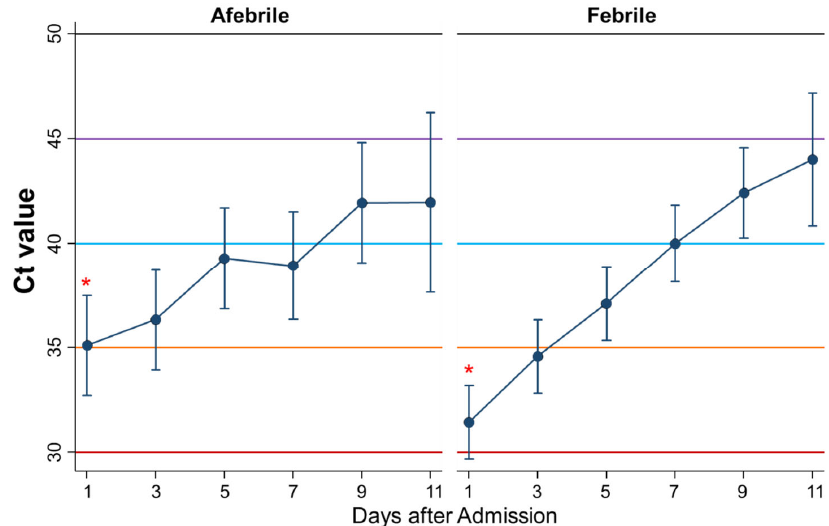
Figure 4. Differential kinetics of the Ct values between afebrile and febrile patients. Mean Ct with 95% confidence intervals. When the Ct value is 40 or more, the PCR test result is considered negative. * represents a significant difference ( p < 0.05 ).